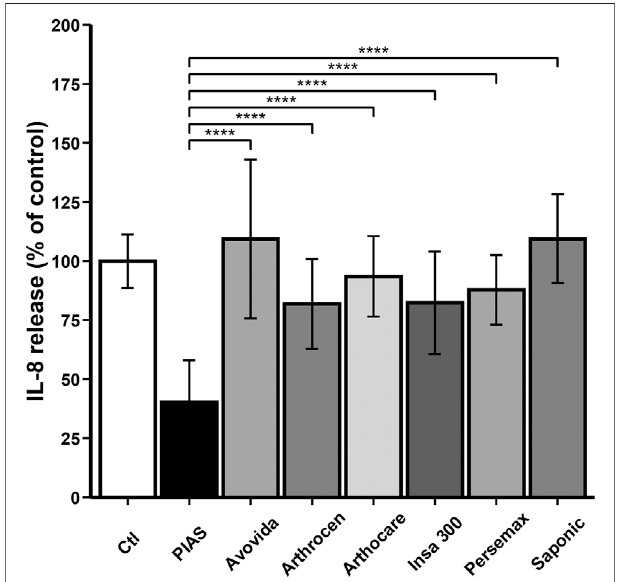
FIGURE 5 | Effect of ASU products tested on total IL-8 production. The chondrocytes were cultured for 12 days either without any ASU (negative control, Ctl) or with 10 µg/ml of either PIASCLEDINE-ExpASU ® (PIAS) or one of the six other nutraceutical products being evaluated in comparison, namely, Avovida, Arthrocen, Arthocare, Insaponi fi able 300 (Insa 300), Persemax, or Saponic. Each product has been tested on six independent cultures. Each culture condition was performed in triplicates. The results are expressed as the percent control and represented by the mean ± SD. **** p < 0.0001 versus PIASCLEDINE-ExpASU ® .